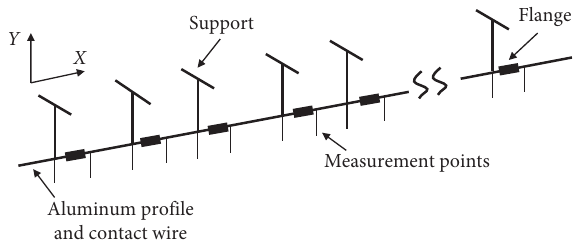
Figure 1: Finite-element model of rigid